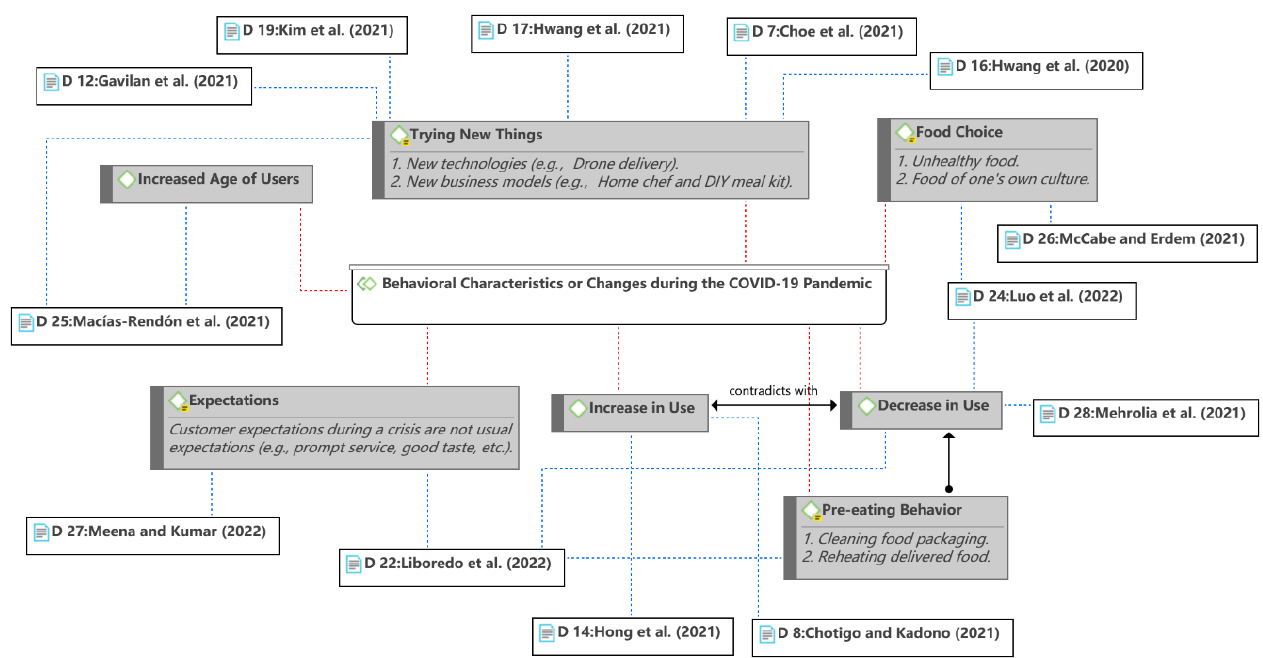
Figure 14. Observed behavioral characteristics or changes [9,15,28,34 – 39,41,45,48,60].